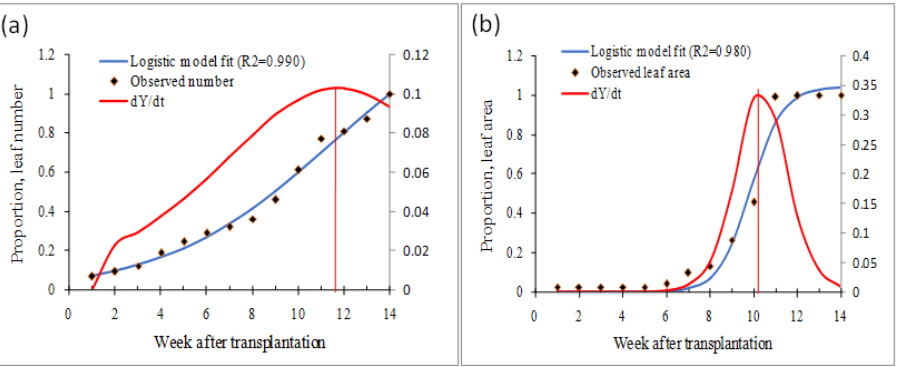
Figure 8. Host density in terms of leaf number ( a ) and area ( b ) in chilli (cv HPH-1041) estimated under controlled conditions.